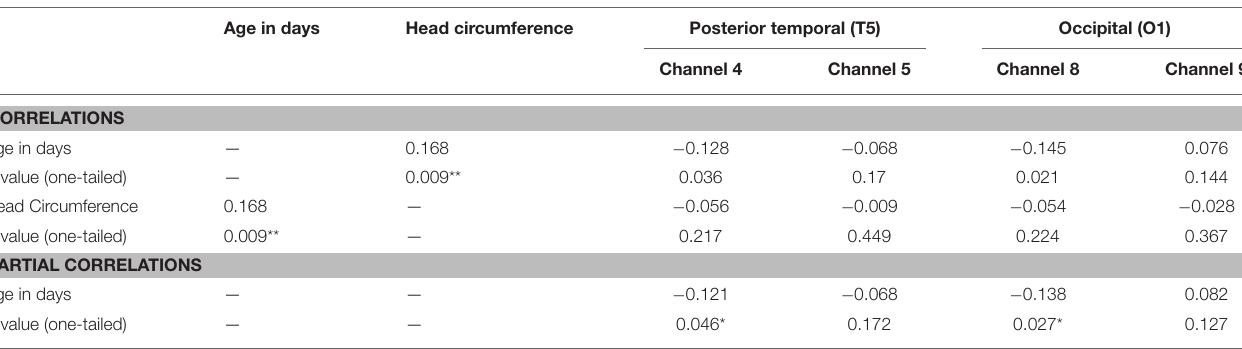
TABLE 2 | Correlation and partial correlation matrixes for Experiment